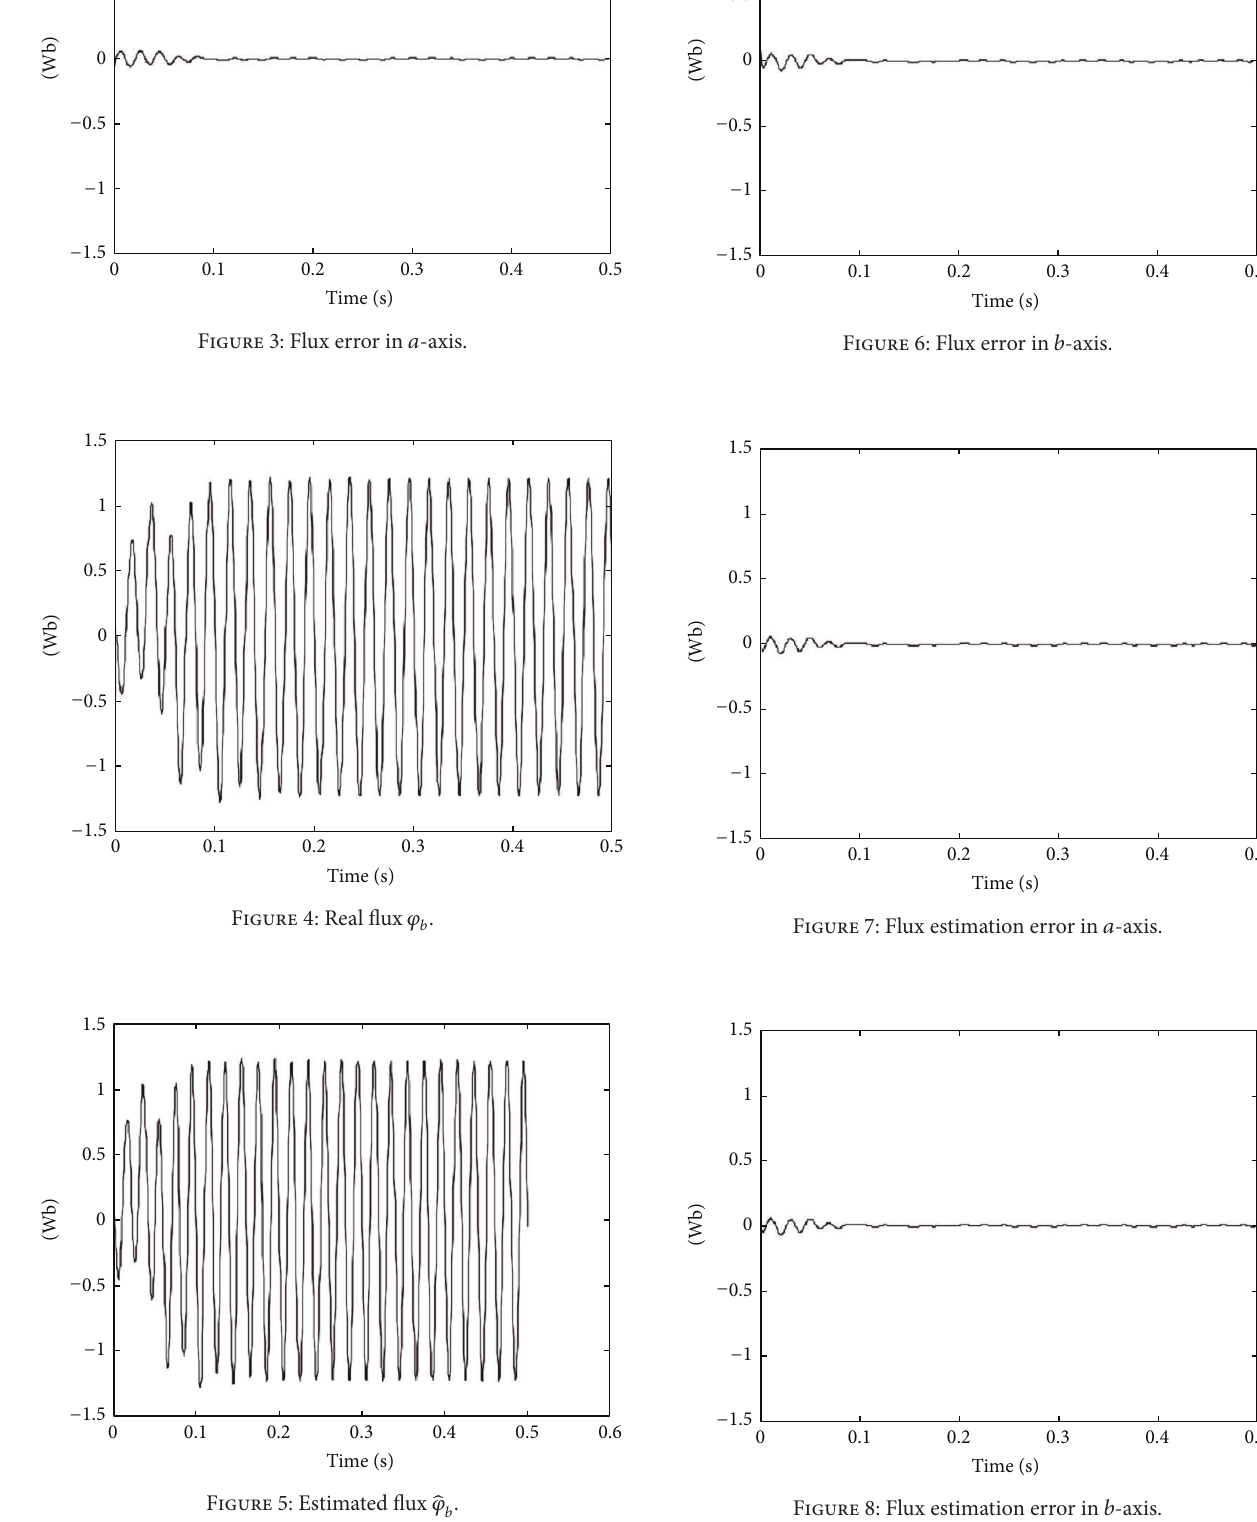
Figure 8: Flux estimation error in 𝑏